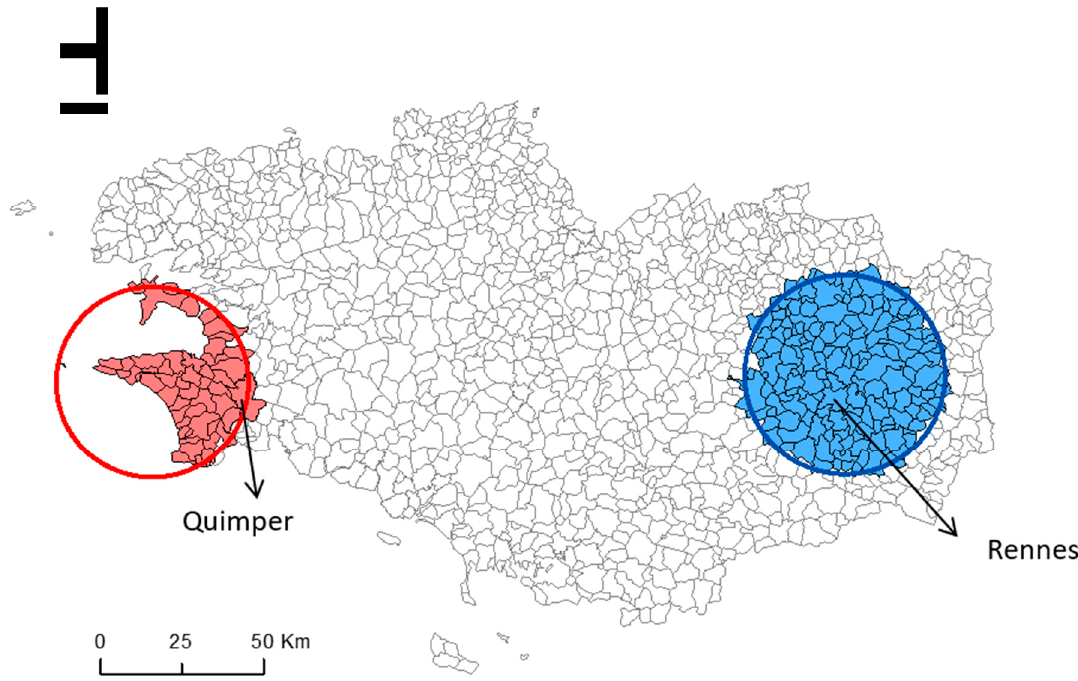
Figure 2. Geographic variations in the risk of emergency first dialysis for patients with end stage renal disease in the 1270 municipalities of the Bretagne region, France. Red circle: cluster of municipalities at higher risk of emergency first dialysis; blue circle: cluster of municipalities at lower risk of emergency first dialysis.